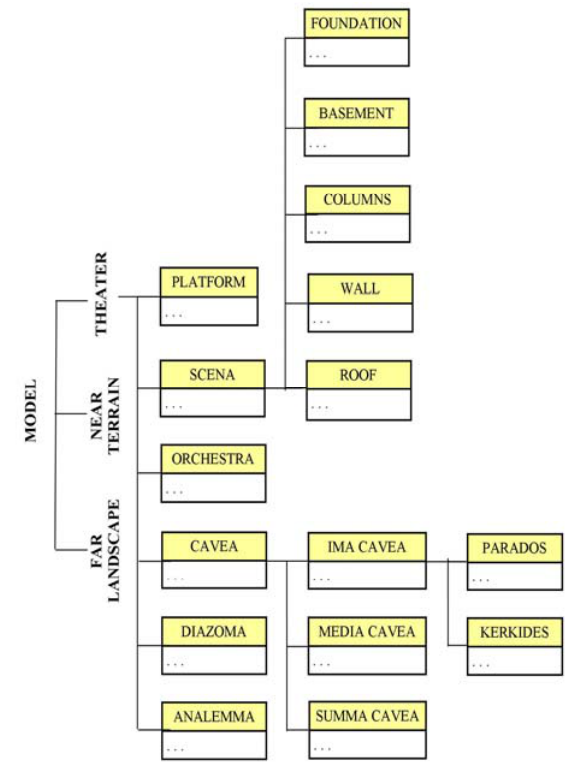
Figure 6. Structure of conceptual model